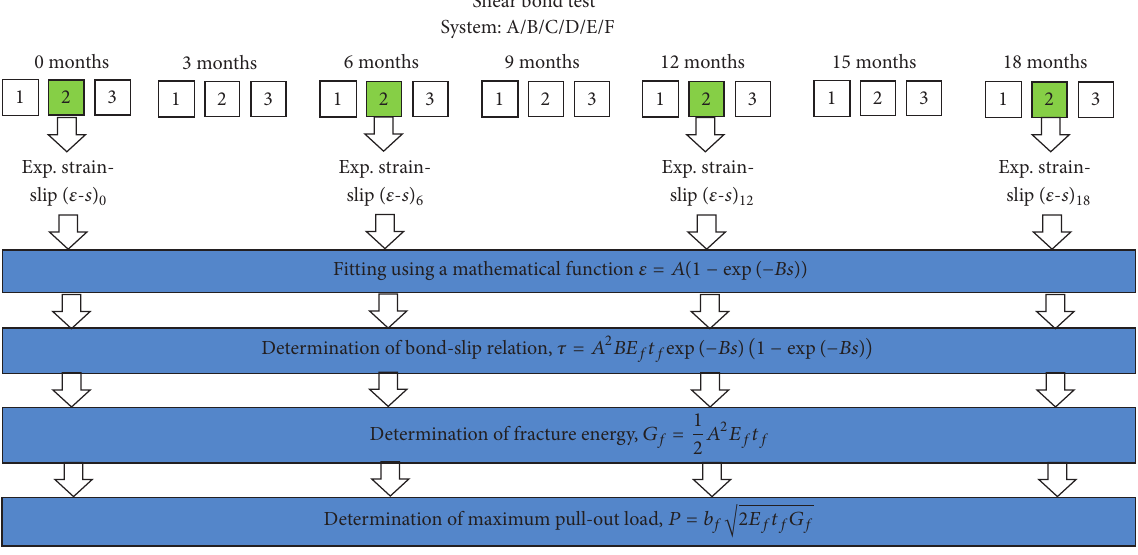
Figure 5: Brief procedure to determine bond-slip relations in moisture conditions. Table 2: Regression coefficients and fracture energies of all the